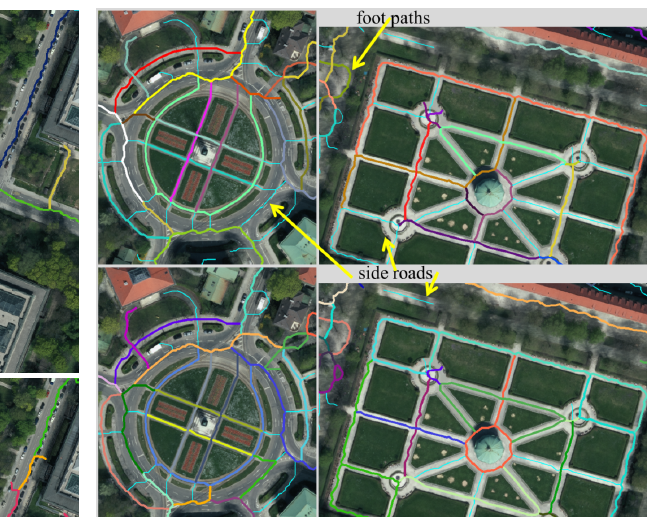
Figure 4: Detailed view of chain forming in case for two traf- fic roundabouts, using partial dominant directions (top row) and RANSAC (bottom